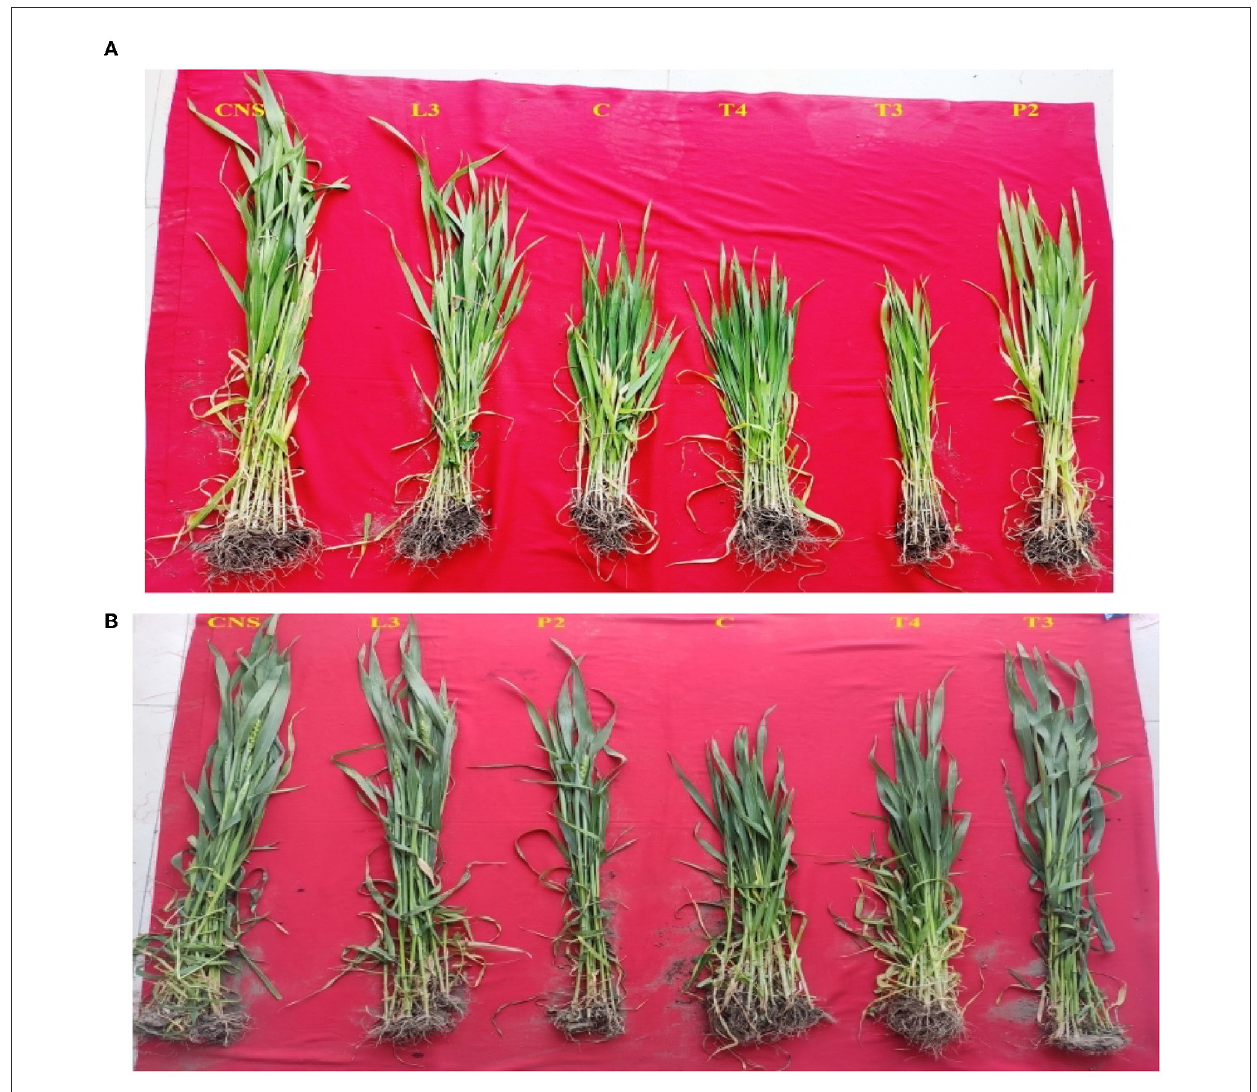
FIGURE4 Variation among the treatment during sampling of field set 1 (A) and field set 2 (B)